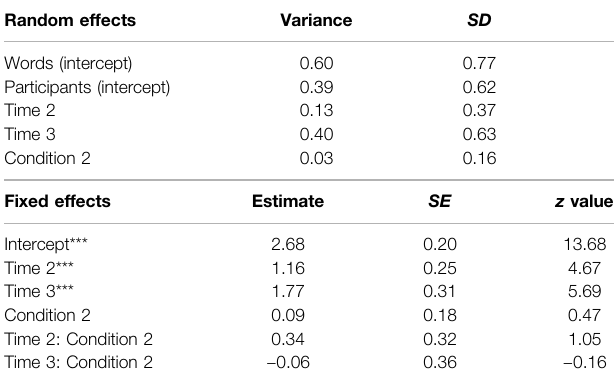
performances in Chinese word and picture pairs (CP) and Chinese word and Japanese word pairs